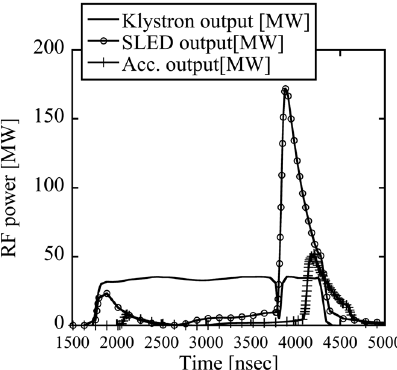
FIG. 10. Waveforms of the klystron output (solid line), the SLED output (open circle), and the output after passing through the accelerating structure (plus